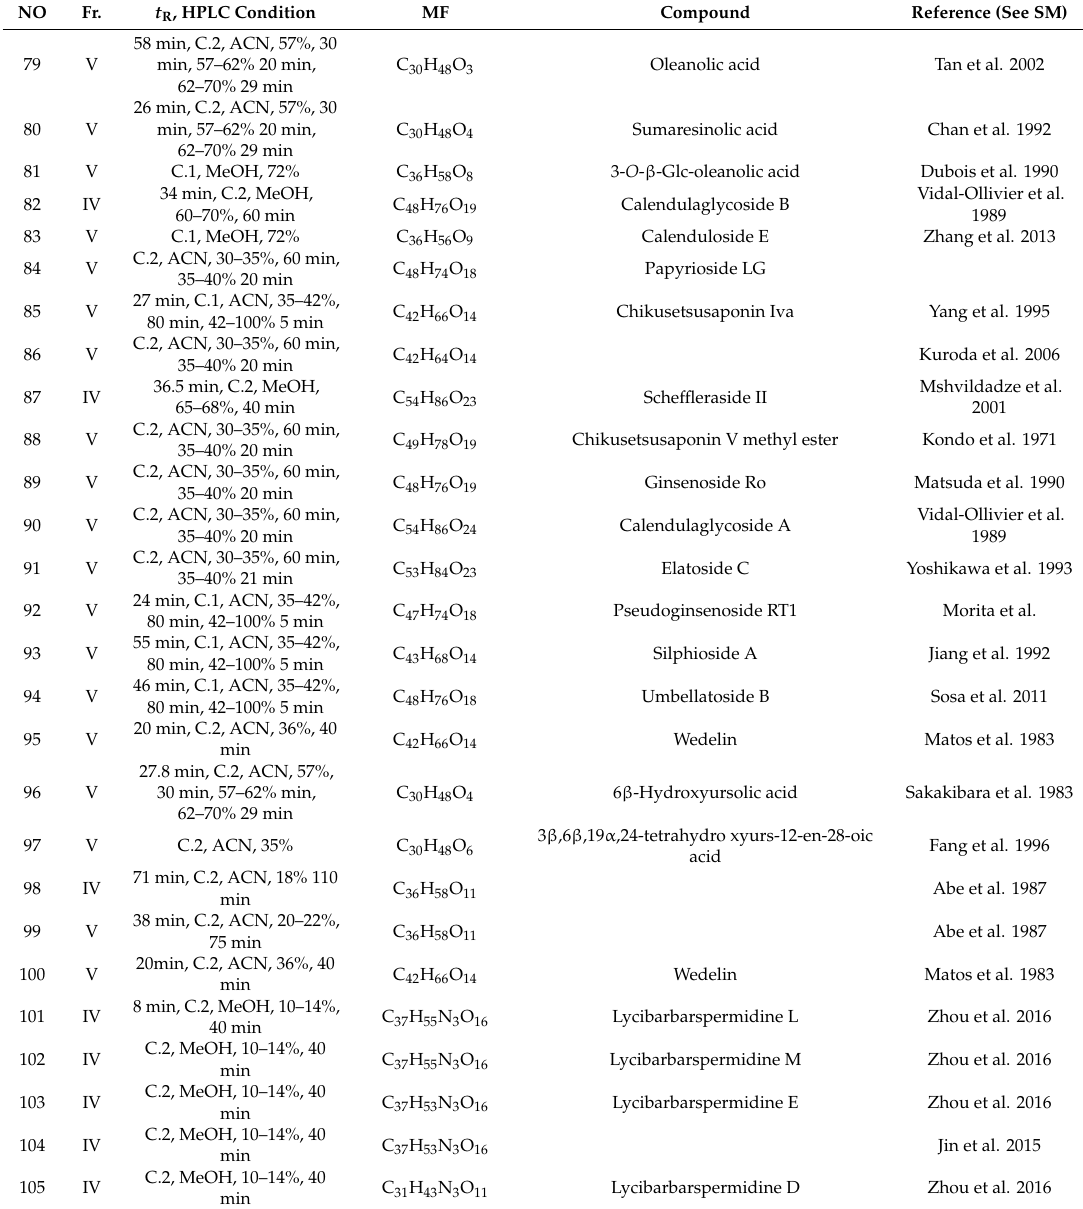
Table 2. Terpenoids (#79–100), alkaloids (#101–118), coumarins, cinnamic acid or coumaric acid,